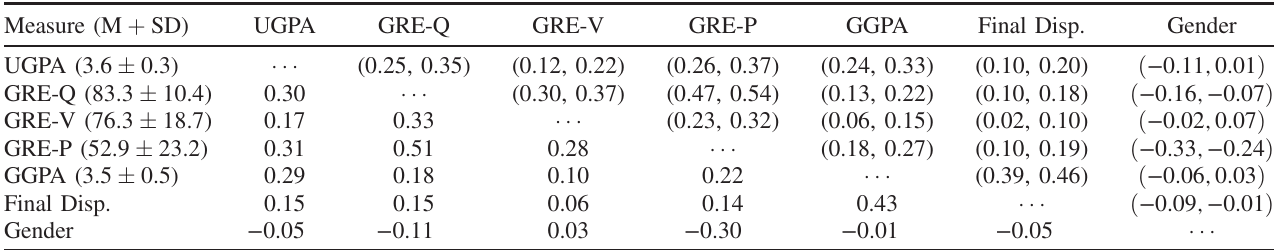
TABLE II. A matrix showing bivariate correlations between continuous and dichotomous variables used in subsequent analyses. Correlations are shown in the lower diagonal while confidence intervals for those correlations are shown in the upper diagonal. For example, the correlation between GGPA and GRE-P is 0.22 and a 95% CI of (0.18, 0.27), indicating a weak correlation. Means and standard deviations are also presented in the first column. GPAs are on a 4.0 scale while GRE scores are in terms of percentiles. Correlations are calculated for U.S. students